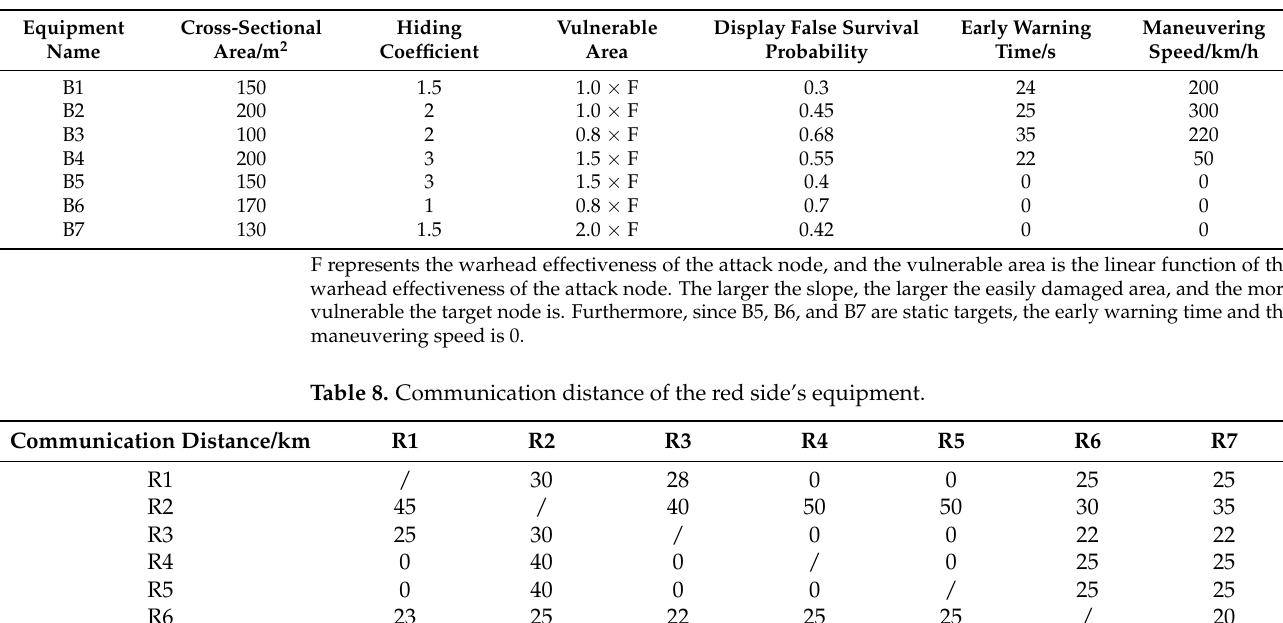
Table 7. Attributes of the blue side’s target nodes.